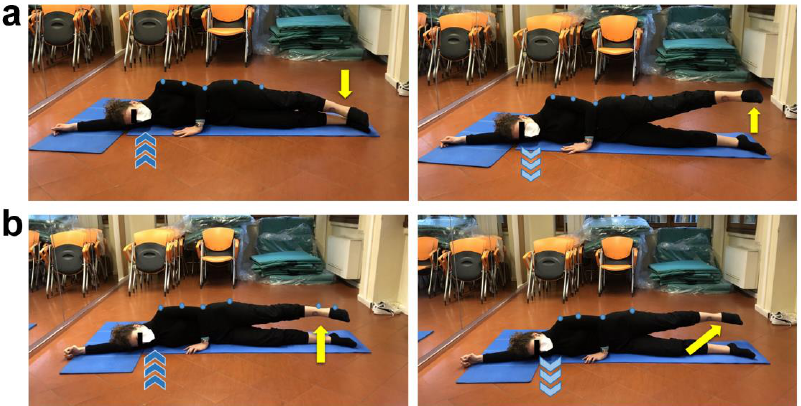
Figure 5. Glutes, abductors, and adductors strengthening exercises in lateral decubitus position. ( a ) Whole body straight in lateral decubitus position (light blue dots) and dorsiflexed feet together (pointing down yellow arrow), keep floor arm straight upward and rest head on it, bend top arm and place hand on the floor in front of the abdomen. Inhale (dark blue arrows) then exhale (light blue arrows) while abducting the top extended lower limb (pointing up yellow arrow). Inhale and get back to starting position. Three sets of 45 s for each lower limb, 30 s of recovery. ( b ) Repeat the previously described exercise adding an abducted lower limb extension on sagittal plane (diagonal yellow arrow), keeping lumbar spine in neutral position. Three sets of 45 s for each lower limb, 30 s of recovery.